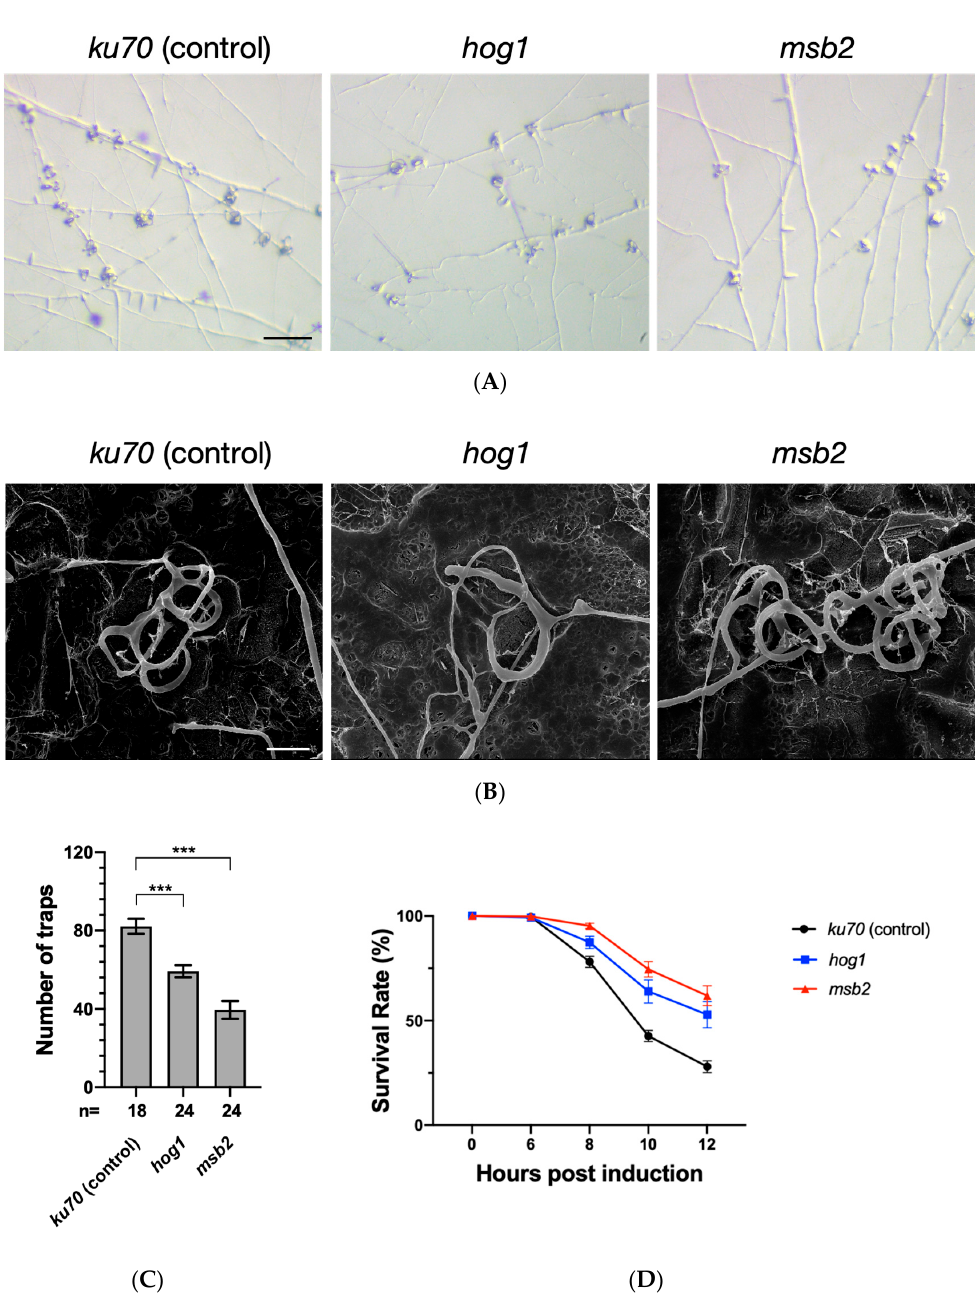
Figure 4. The HOG1 MAPK pathway is involved in proper formation of traps during nematode induction. ( A ) Representative brightfield images of the traps induced by N2 C. elegans in the ku70 (control), hog1 , and msb2 mutants. (Scale bar, 200 µm). ( B ) Representative SEM images showing defective trap network formation by the hog1 mutant. (Scale bar, 25 µm). ( C ) Quantification of the trap numbers induced by N2 C. elegans for the ku70 (control), hog1 , or msb2 mutant lines. (Mean ± SEM; n shown along the x axis; asterisks represent significance levels of unpaired t test compared to the control. *** p < 0.001.) ( D ) Survival rates of nematodes upon exposure to the ku70 (control), hog1 , or msb2 mutant lines. (Mean ± SEM; n =